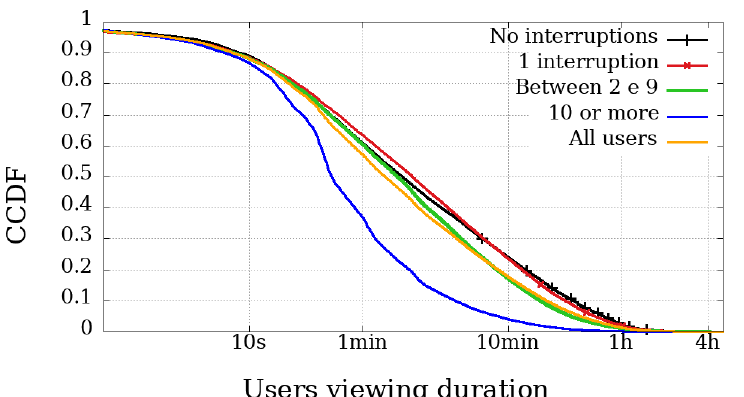
Figure 7. Complementary cumulative distribution function of the viewing duration from users, grouped by the amount of interruptions experienced in the transmission session of the Impeachment start session— Camara dos Deputados —non-mobile devices.